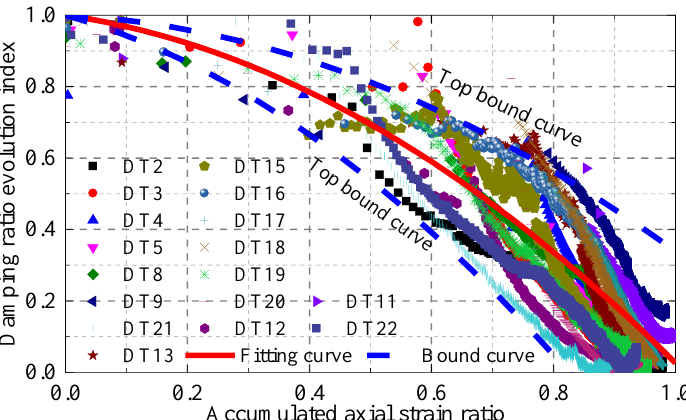
Figure 9. Relationship between the accumulated axial strain ratio and the damping ratio evolution index.